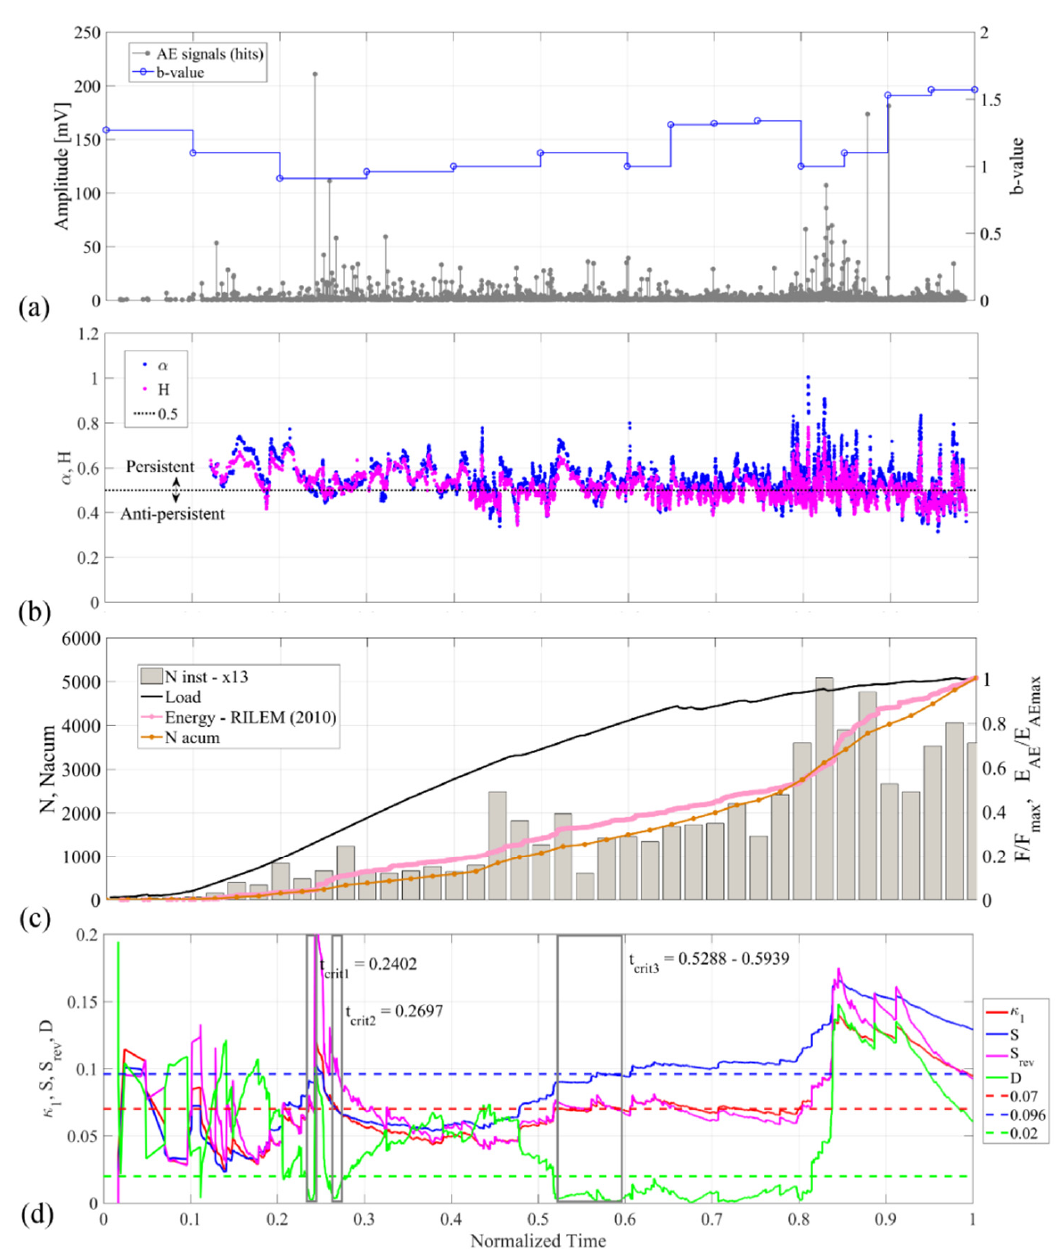
Figure 7. ( a ) AE signals with b -value analysis; ( b ) Number of instantaneous signals, number of accumulated signals, applied load, and accumulated energy versus normalized time. The first was multiplied by 13 to maintain the same vertical scale for instantaneous and accumulated signals; ( c ) Application of Hurst and DFA methods to the AE data; ( d ) NT analysis of the AE time series with threshold values ( A max1.5 ) Th = 0.25 mV. The following auxiliary horizontal lines were added: κ 1 = 0.070 (dashed red), (cid:104) D (cid:105) limit = 10 − 2 (dashed green), entropy limit Su ≈ 0.0966 (dashed